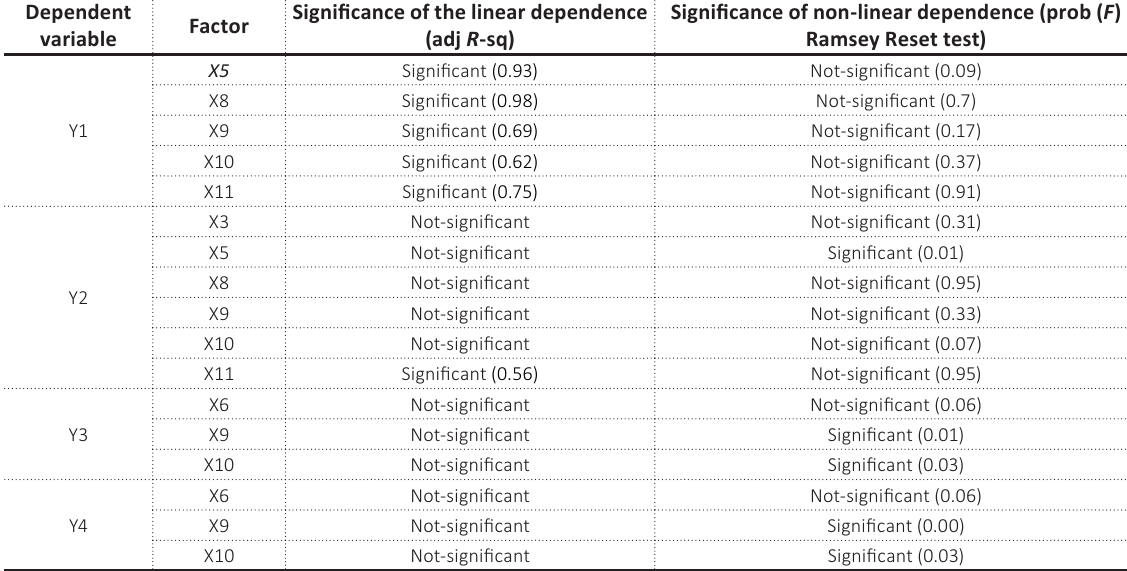
Table 4. Linear regression modeling and Ramsey RESET test Dependent